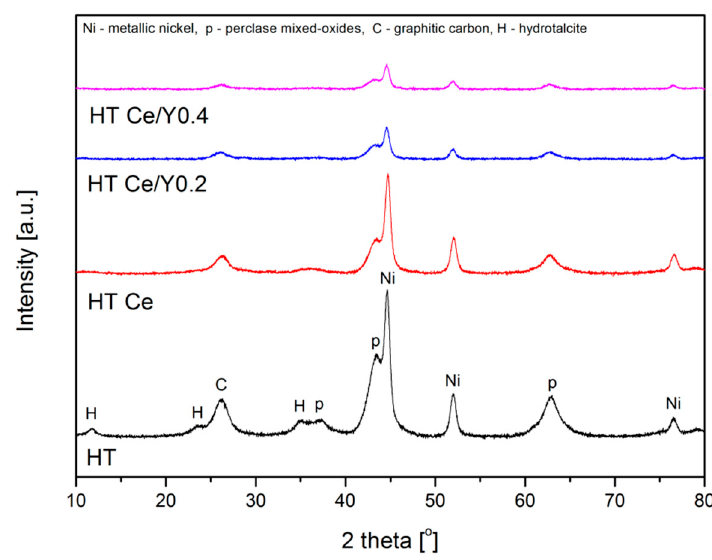
Figure 7. XRD diffractograms recorded for the spent catalysts after isothermal tests at 700 °C for 5 h.